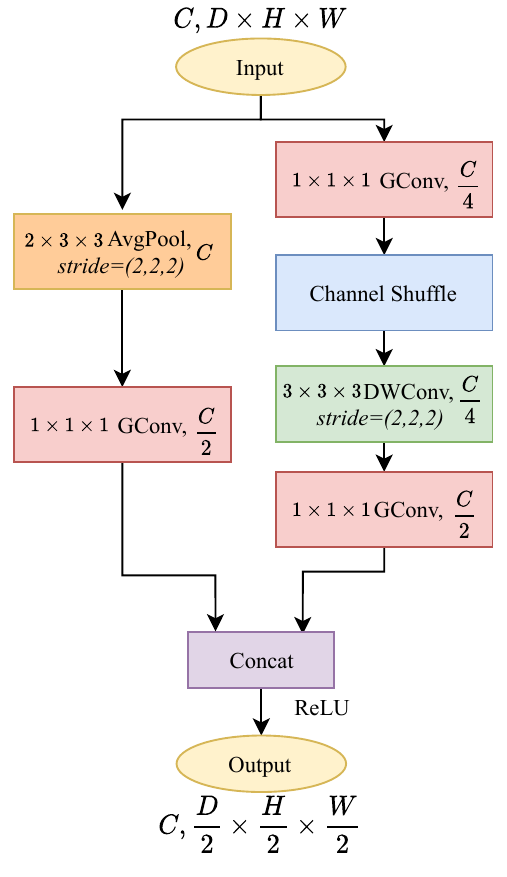
Figure 4. The implementation of 3D ShuffleNetV1 with stride = 2 at 3 DStack 3_ x layer. Following the PSMNet, we downsample the cost volume by half without changing the